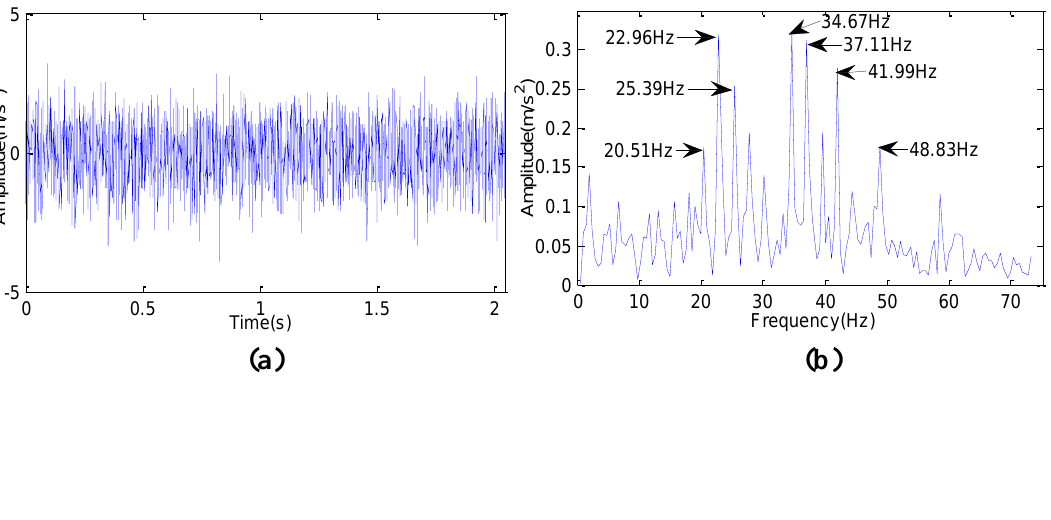
Figure 13. Comparison on spectrum of Fourier Transform and wavelet lifting analysis of the original signals. (a) time domain waveform of the original signal; (b) spectrum after Fourier transform of the original signal; (c) time domain waveform of approximation signal reconstruction after decomposition to wavelet lifting at level three; (d) spectrum analysis of wavelet